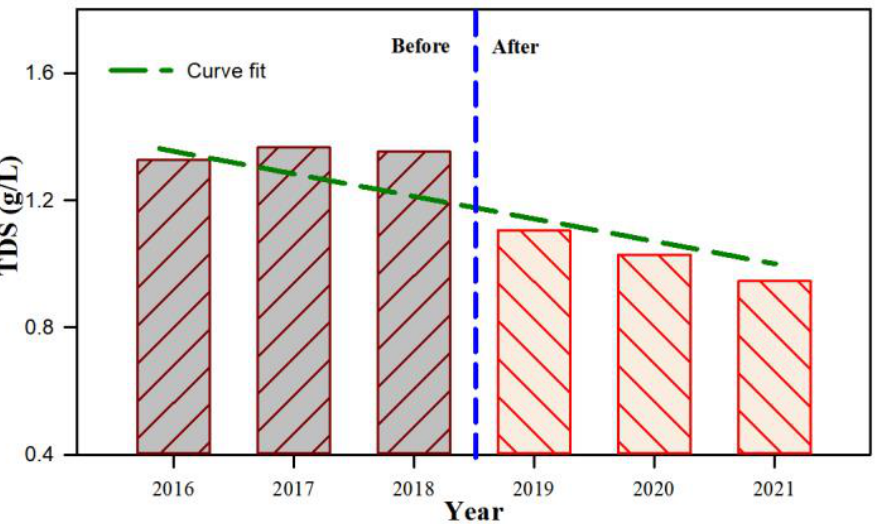
Figure 9. Changes in average annual TDS content of lake water before and after water diversion implementation in Bosten